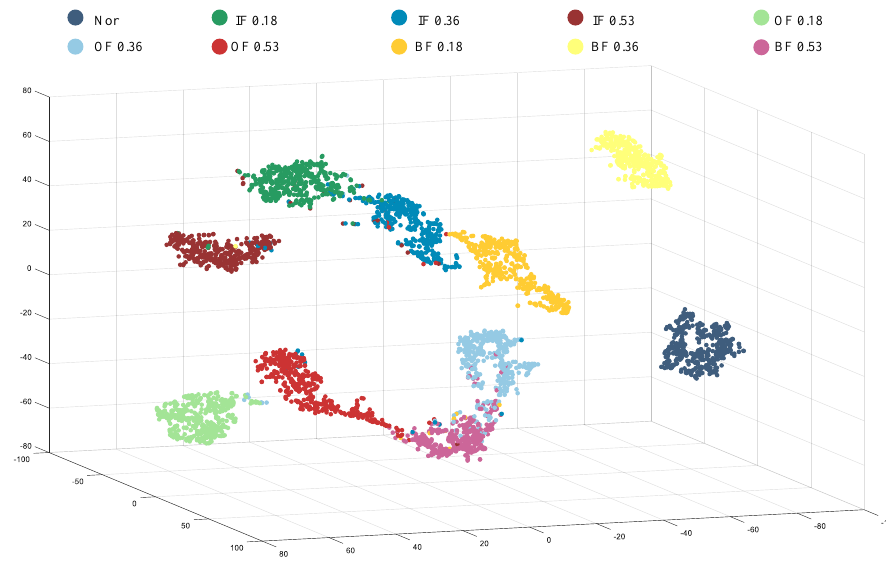
Figure 13. Visualization of features of validation dataset processed by t-SNE.